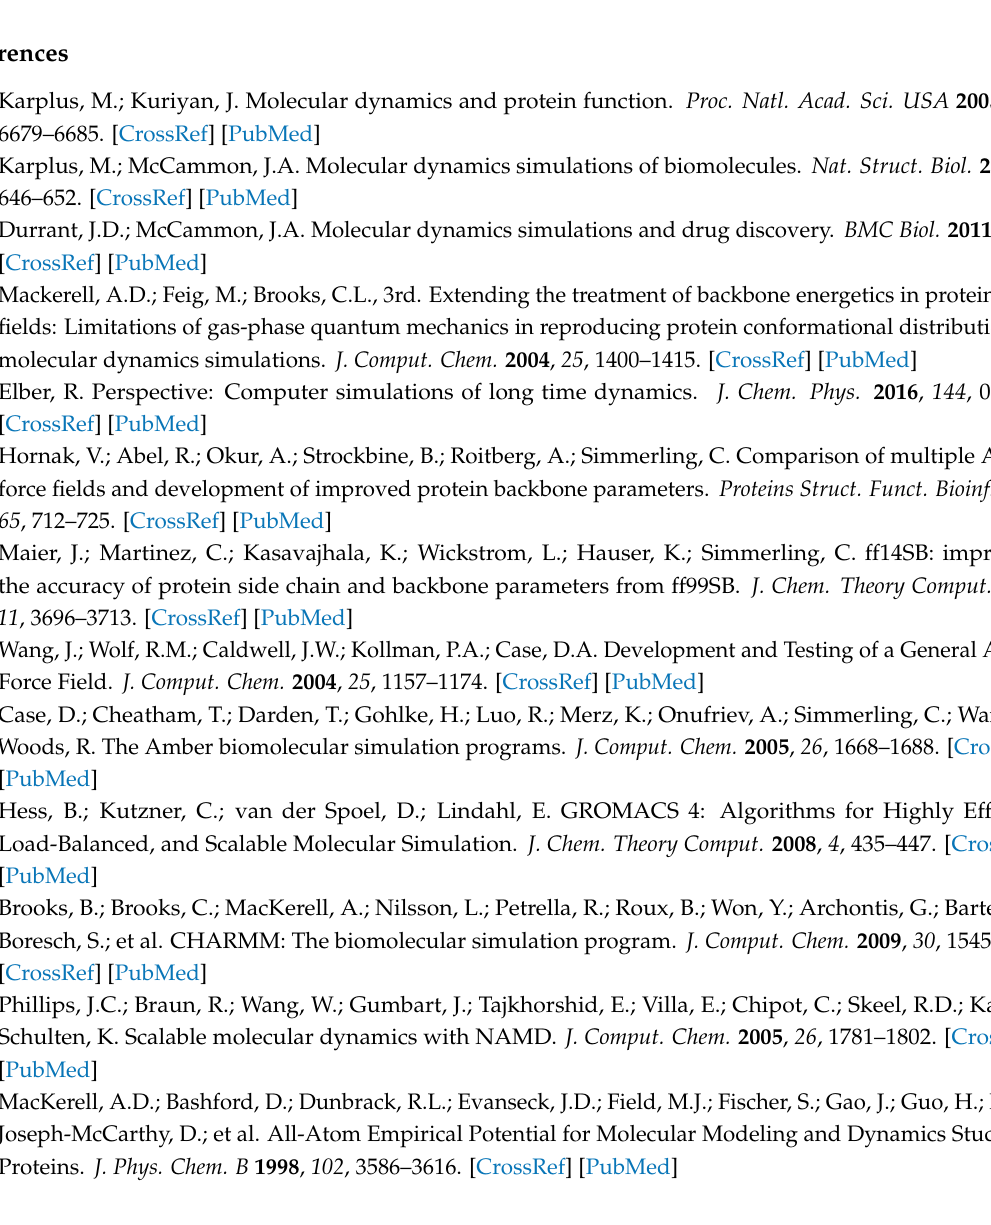
AMBER99 forcefield. Figure S11: Results from path- and PMF-sampling simulations of Penta-alanine with one Ala-Ser mutation: Ace-Ala-Ser-Ala-Ala-Ala-NMe using the AMBER99 forcefield. Figure S12: Results from path- and PMF-sampling simulations of Penta-alanine with one Ala-Ser mutation: Ace-Ser-Ala-Ala-Ala-Ala-NMe using the AMBER99 forcefield. Figure S13: Summary of PMF-sampling simulations for penta-alanine and the mutated versions from the path sampling